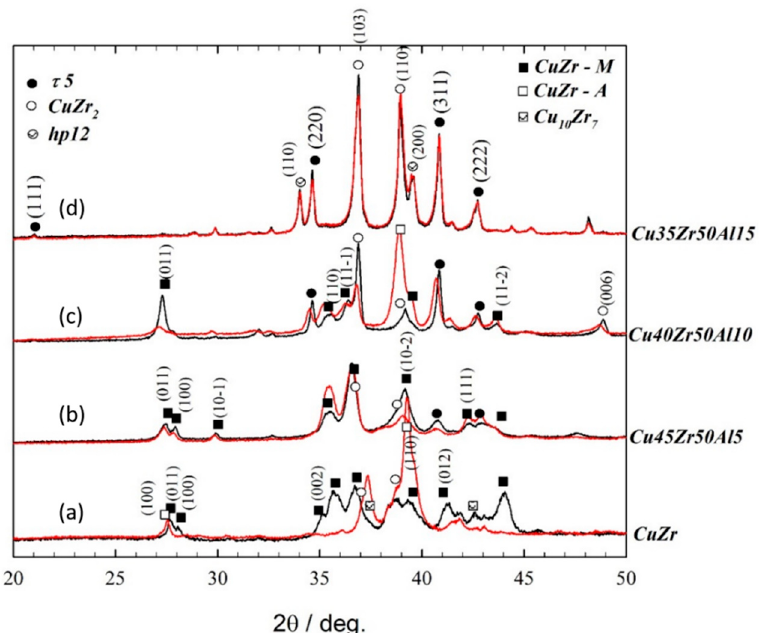
Figure 2. Section of experimental patterns of binary equiatomic (a) and ternary alloys (b–d) at room temperature, before (black curve) and after (red curve) the tenth thermal cycle. The reflections of the τ 5 phase are explicitly indicated.